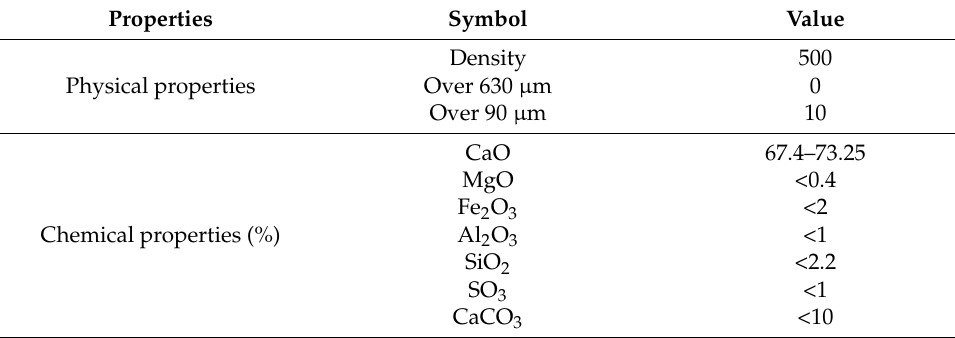
Table 3. Properties of clay used.